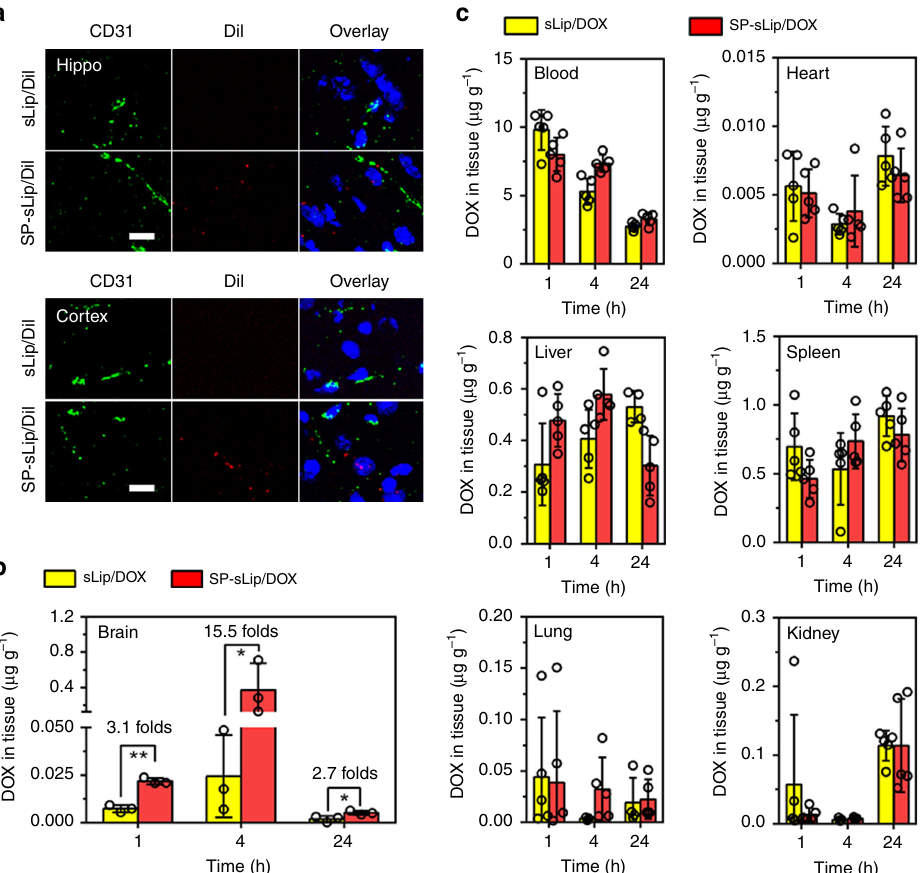
Fig. 4 Biodistribution of sLip and SP-sLip in healthy BALB/c mice. a DiI-labeled sLip (sLip/DiI) and SP-sLip (SP-sLip/DiI) were injected via tail vein and brains were dissected and sectioned at 4 h after administration. Brain slices were stained with anti-CD31 antibody (green) and biodistribution of liposomes (red) in hippocampus (Hippo) and cortex were observed by confocal laser scanning microscopy. Scale bar = 20 μ m. Doxorubicin distribution in brain ( b ) and other main organs ( c ) at 1 h, 4 h, and 24 h after intravenous injection of SP-sLip/DOX and sLip/DOX. Data are means ± SD ( n = 3 – 5). * p < 0.05, ** p < 0.01 by student ’ s t -test